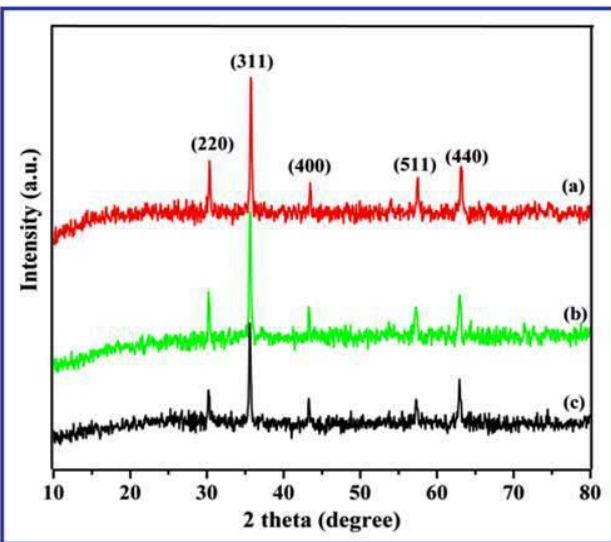
Figure 1. XRD patterns of γ -Fe 2 O 3 nanostructures synthesized using different % (1%, 2% and 3%) of